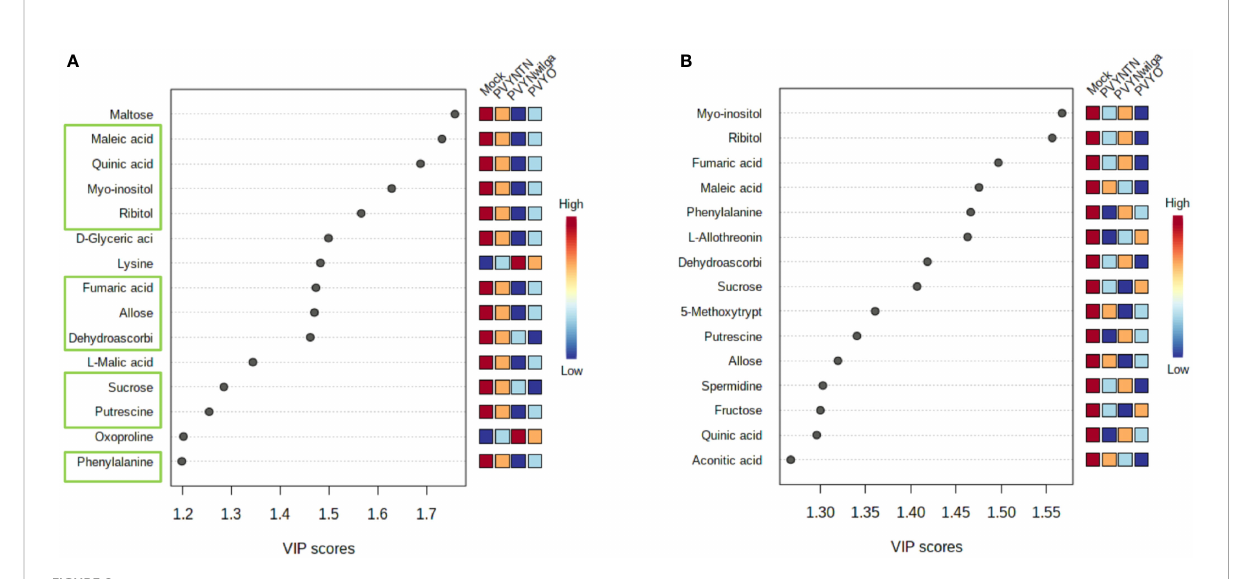
FIGURE 2 Important features selected by Partial Least Squares Discriminant Analysis (PLS-DA). (A) Top 15 features that discriminate infections of potato virus Y (PVY) in Premier Russet, and (B) Russet Burbank. Discriminatory metabolites that overlap between the two cultivars are highlighted in green boxes (A)